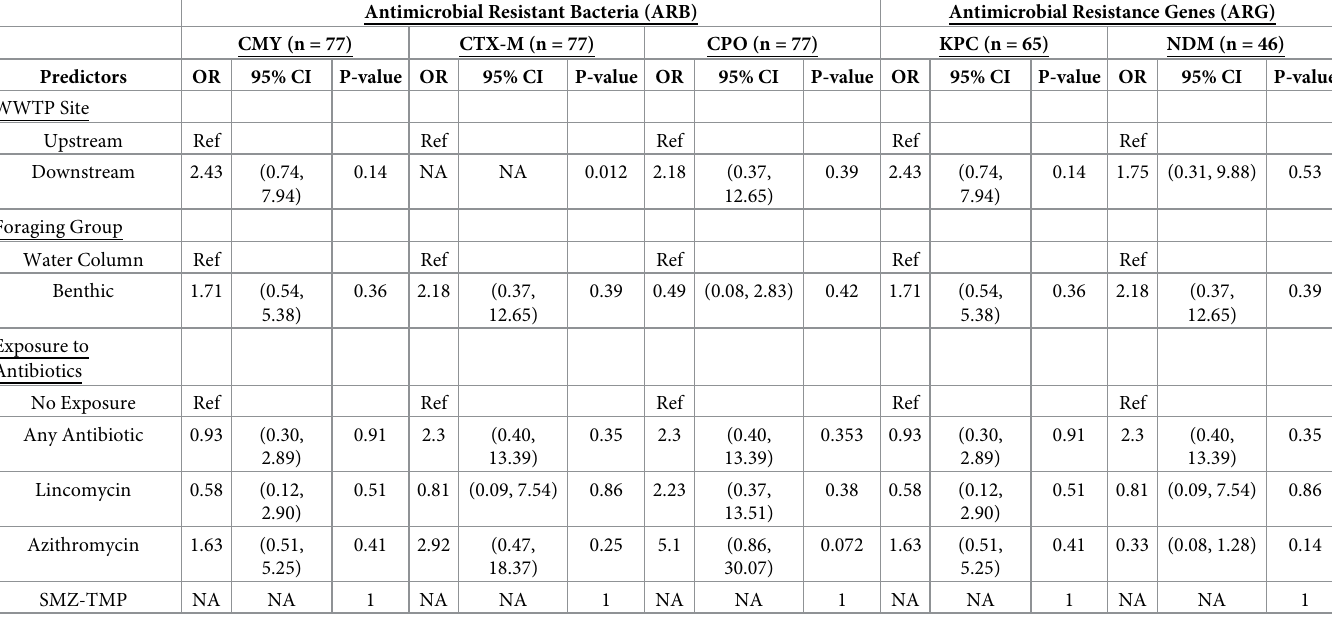
Predictors with “Ref” values are referent groups. Predictors with NA values for odds ratios (OR) and 95% confidence intervals (95% CI) are associations that were evaluated by Fisher’s Exact